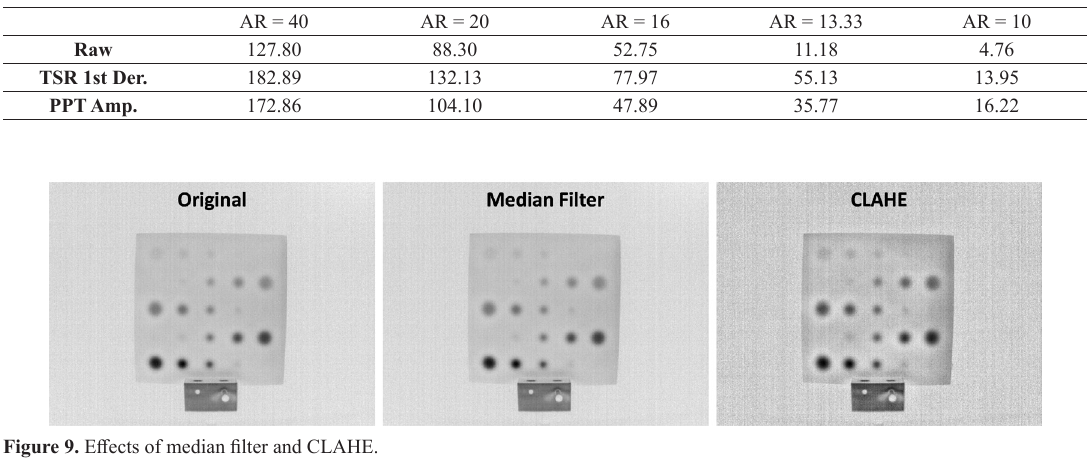
Table 1. Absolute contrast values for the 20 mm flat-bottom holes, for the raw and pre-processed thermograms.